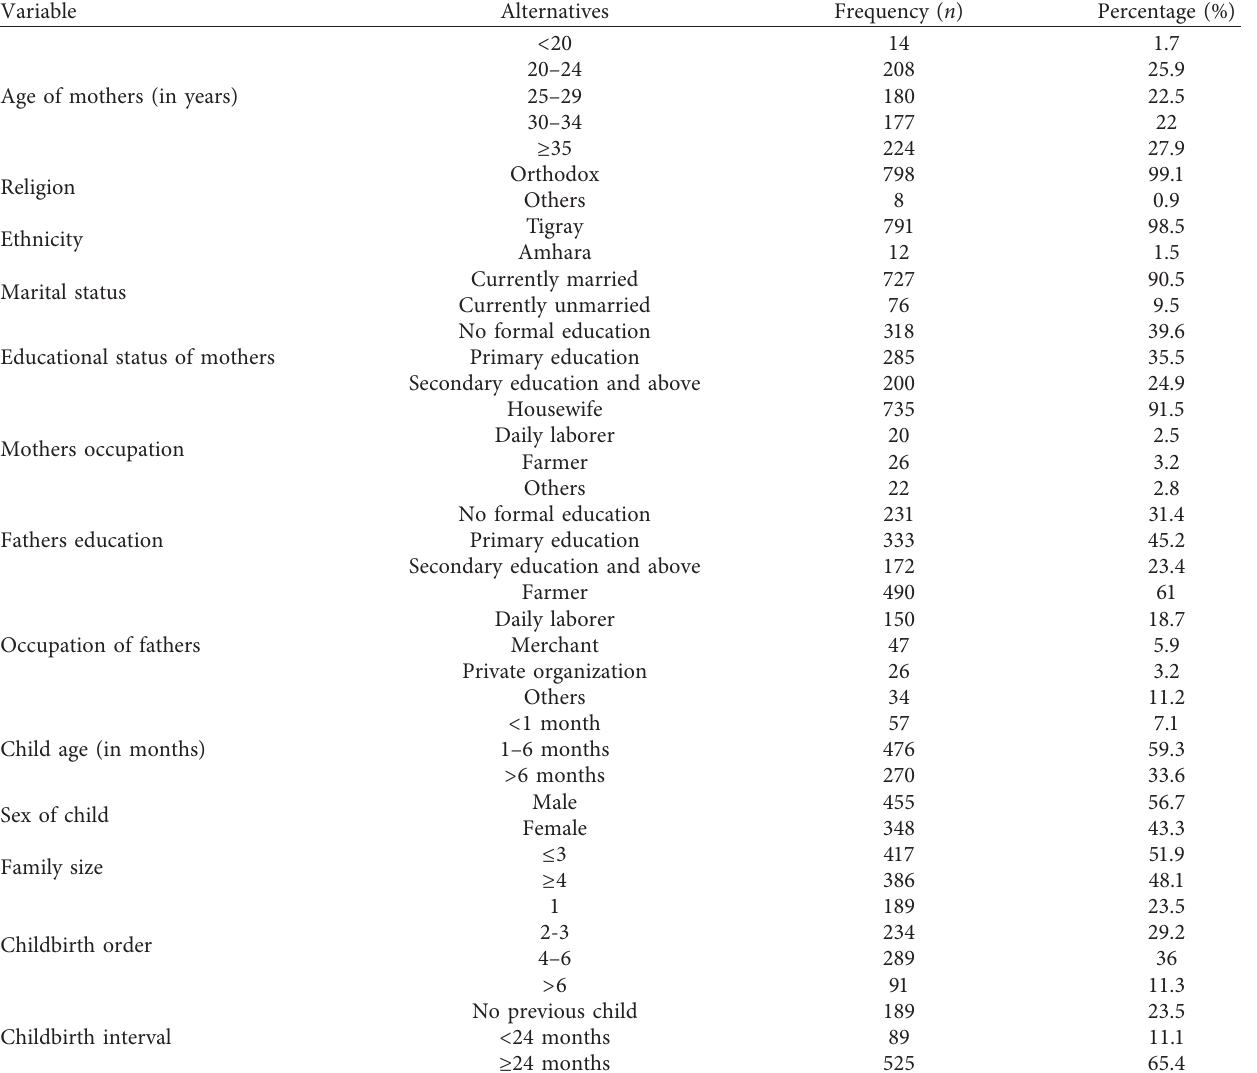
Table 1: Sociodemographic characteristics among mothers of children aged less than 12 months in rural eastern zone, Tigray, Ethiopia, 2018 ( n �